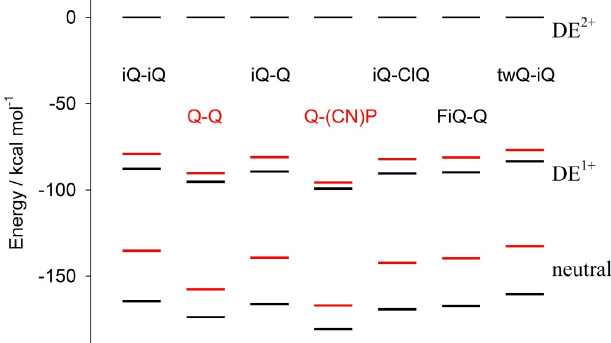
Figure 8. Calculated energy of the cations and neutral molecules with respect to the energy of the dication parent species (assumed to be zero). The black and red bars correspond to the optimized or dication quenched geometry, respectively. The data were obtained at the B3LYP/6-31G(d) level of the theory. Table 2. Dihedral angles between rings obtained from calculations. The data were obtained at the B3LYP/6-31G(d) level of the